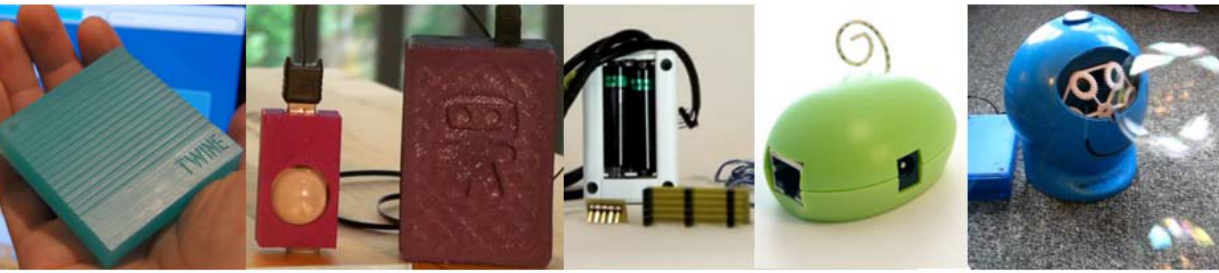
Figure 11. Consumer-ready IOT Sensor Platforms and Gadgets: Twine, Ninja Blocks (an early prototype), knut, Green Goose, and